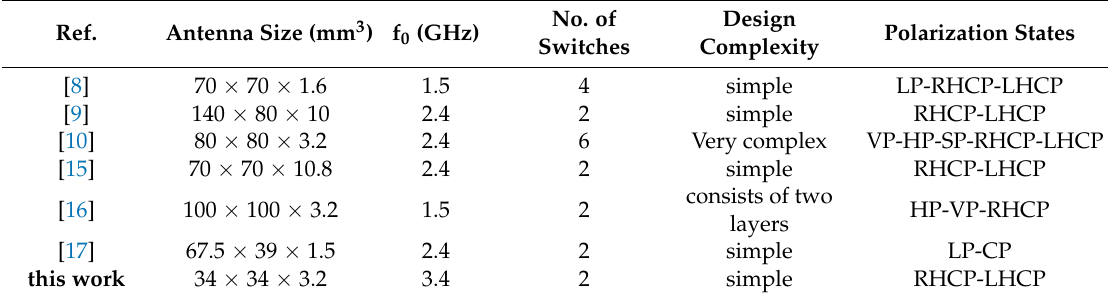
Table 2. Comparison between the proposed design and others.